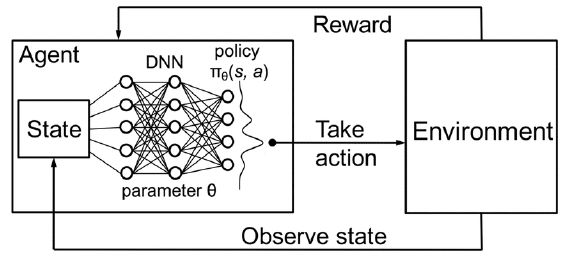
Fig. 5. Deep RL design